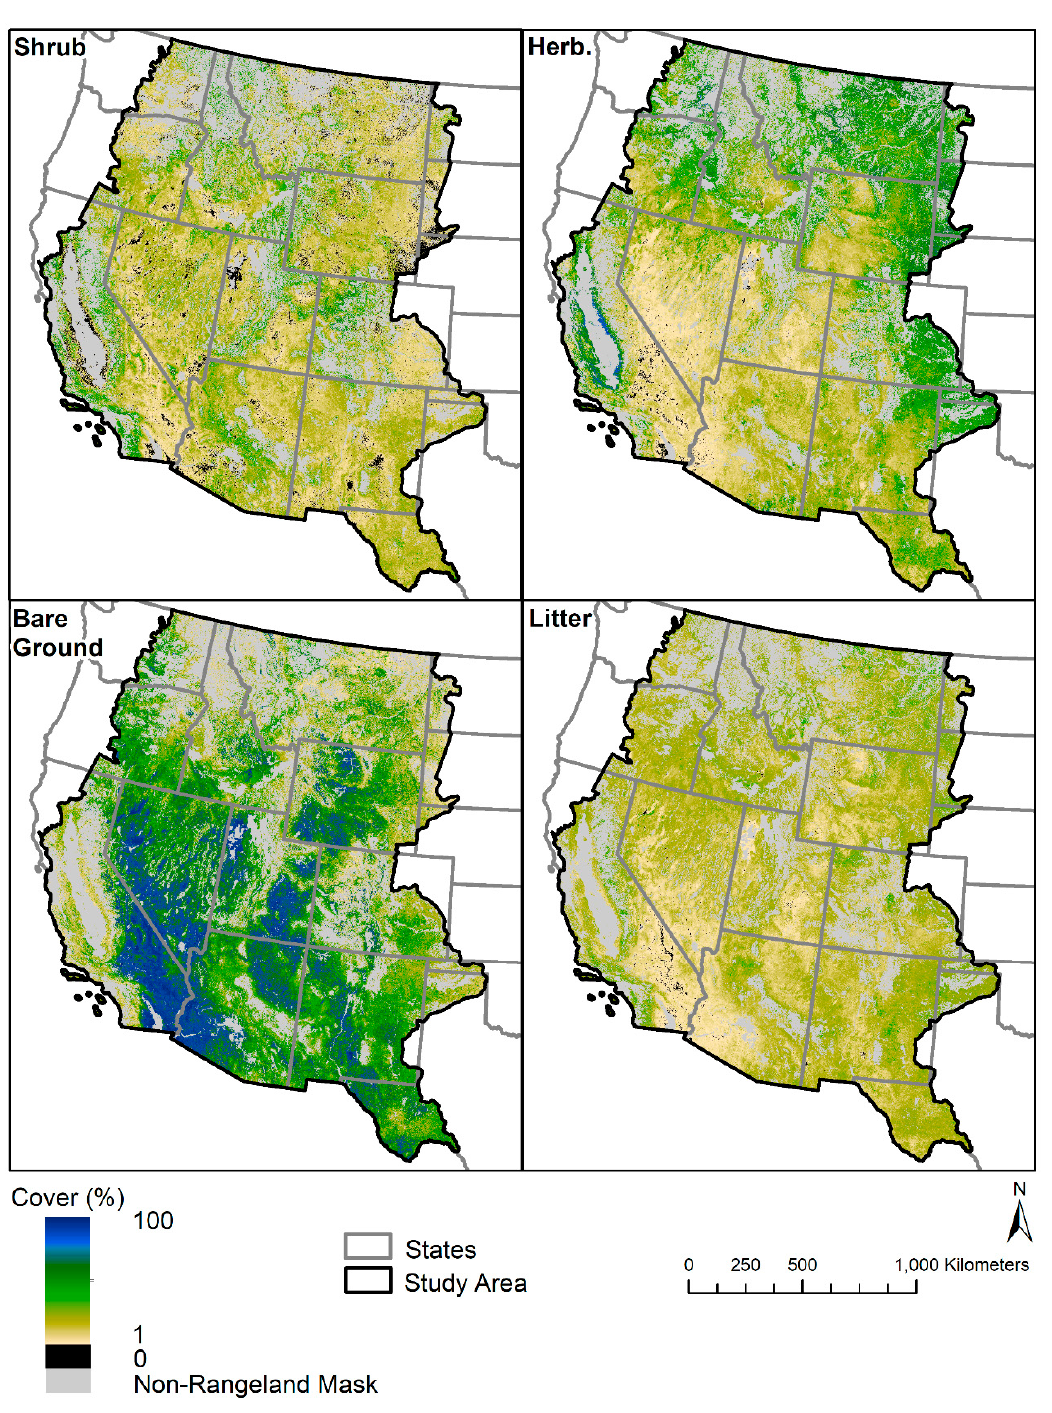
Figure 3. Distribution of primary fractional cover components; shrub, herbaceous, bare ground, and litter in the western U.S.